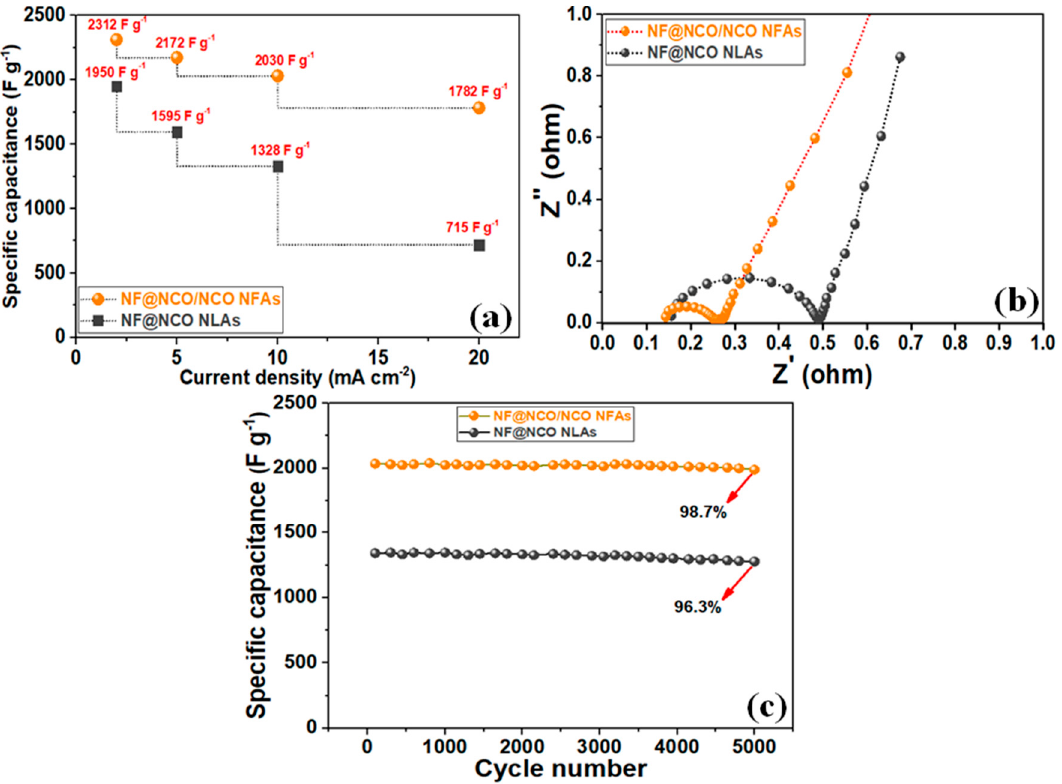
Figure 5. ( a ) Specific capacitance at various current densities, ( b ) Nyquist plots, and ( c )